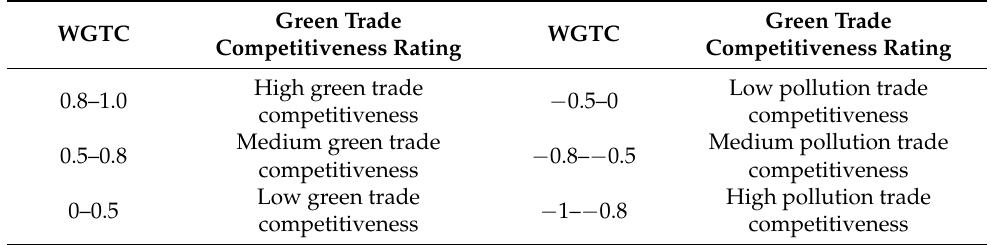
Table 2. Green evaluation criteria of trade competitiveness index for wooden forest